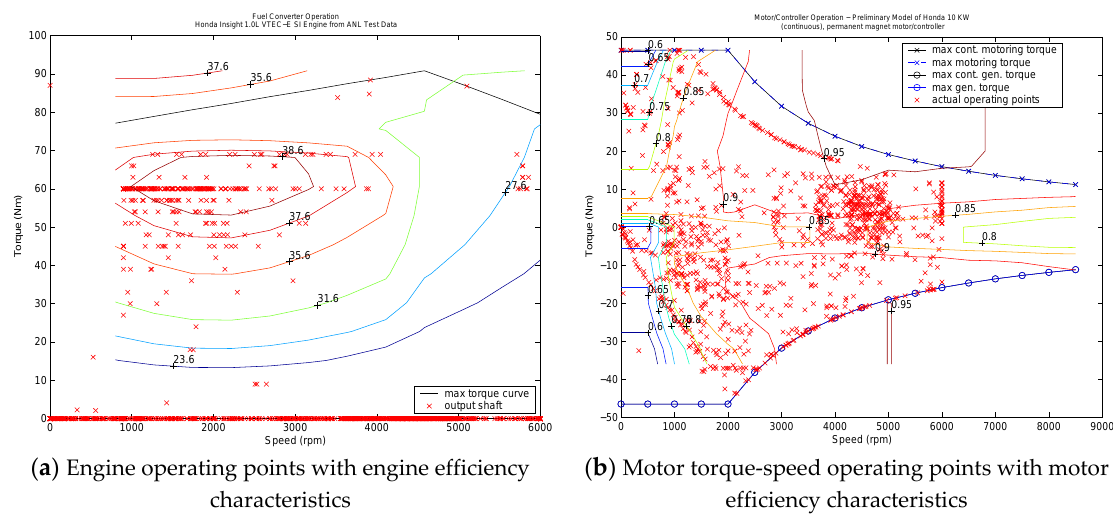
Figure 8. Torque-speed operating points of engine and motor using the SDP EMS.